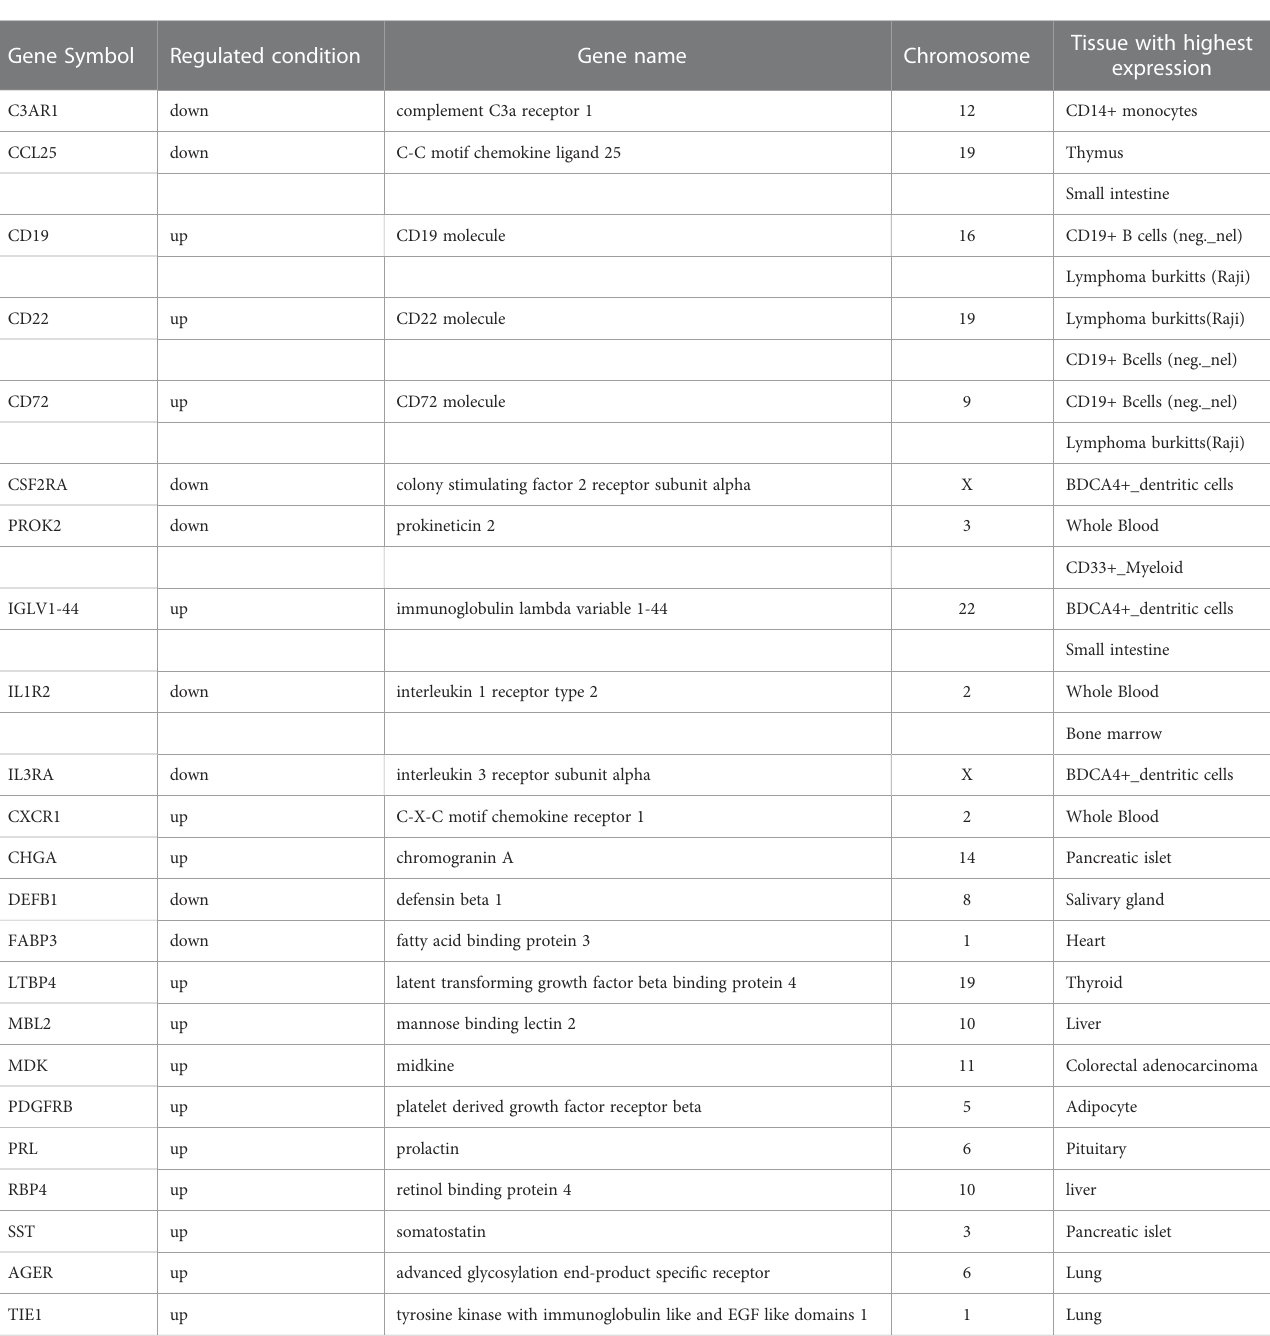
TABLE 2 The tissue-speci fi c genes in Xp TS patients.